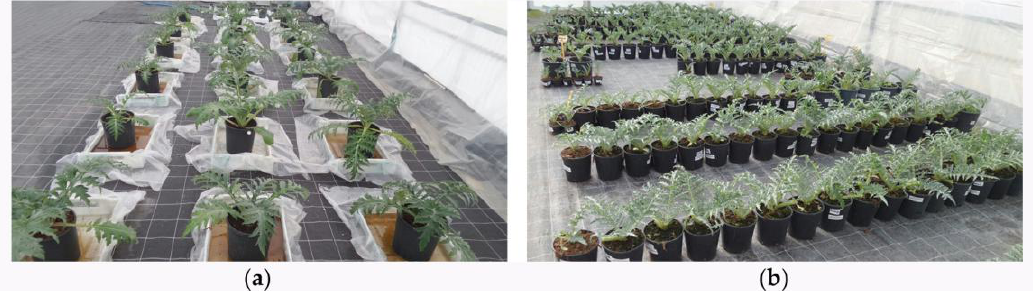
Figure 3. RT-PCR performed with primer pairs specific for ( a ) ArLV; ( b ) AILV and ( c ) TICV on nucleic acid extracted from primary sources of the five ecotypes of globe artichoke (BT, Bianco di Taranto; Fr, Francesina; VeP, Verde di Putignano; ViP, Violetto di Putignano; LM, Locale di Mola).